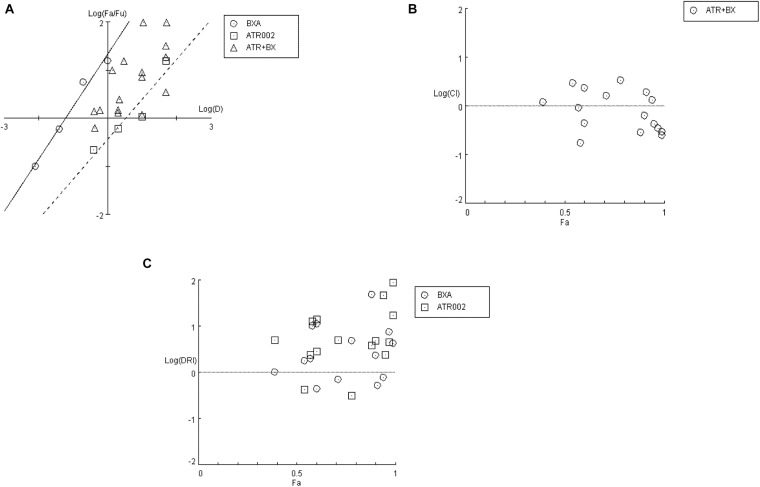
Analysis of BXA/ATR-002 combinations (Supplementary Table 4) with CompuSyn software. (A) Median-effect plot (ME-plot) for BXA and ATR-002. This plot generated by plotting the log values of x = D (dose) versus y = fa/fu (fraction affected/fraction unaffected) and the Dm calculated according to the median-effect plot equation. (B) Logarithmic Combination Index Plot. Synergism/antagonism were plotted as the Log (CI) on the y-axis versus the Fraction affected (Fa) on the x-axis. Combinations with CI value CI = 1 are additive and plotted on, or near the horizontal line, combinations with CI < 1 are synergistic and plotted below the horizontal line, and combinations with CI > 1 indicate antagonism and plotted above the horizontal line; (C) Fa-DRI plot of BXA and ATR-002 against influenza virus. DRI values above 1 [log (DRI) = 0] represents favorable drug dose reduction for each drug, DRI = 1 and <1 indicate neutral, and negative dose-reduction, respectively (Supplementary Table 5).